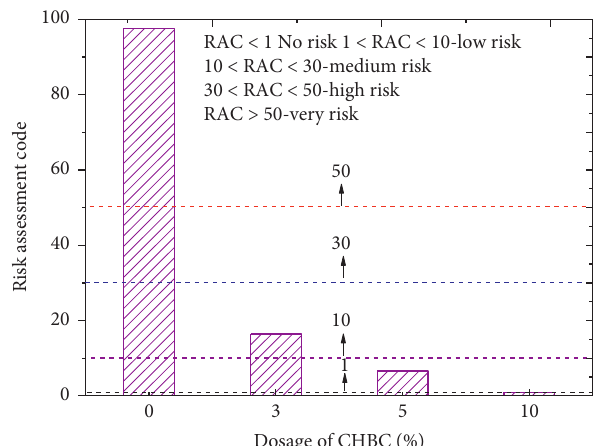
Figure 8: Effect of CHBC dosage on risk assessment of stabilized soils.